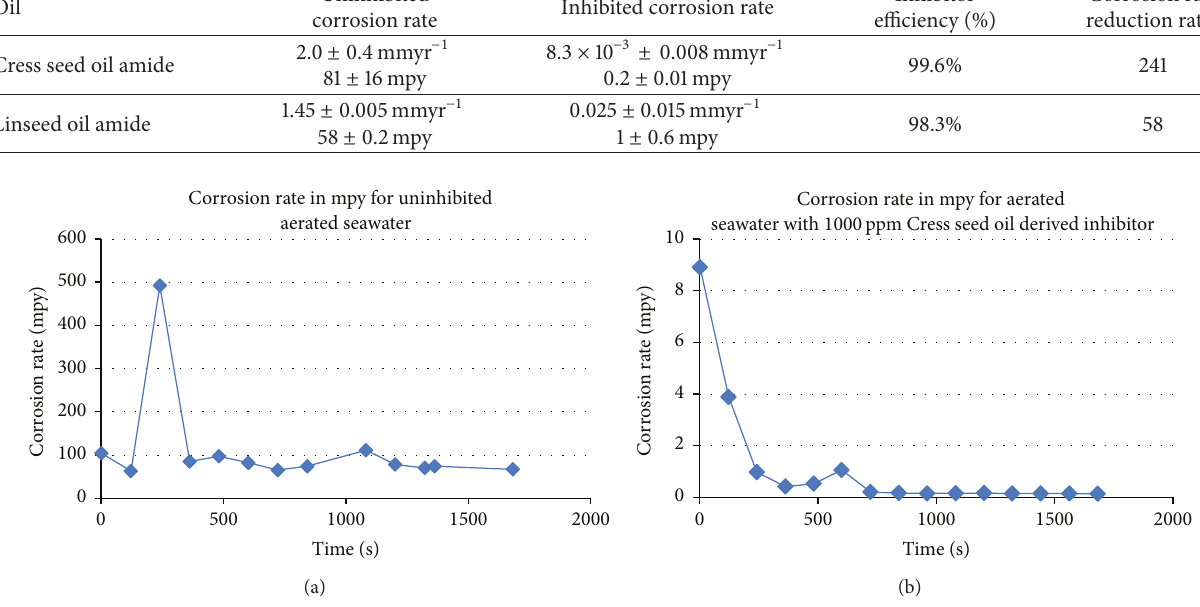
Inhibitor Corrosion rate efficiency (%) reduction ratio